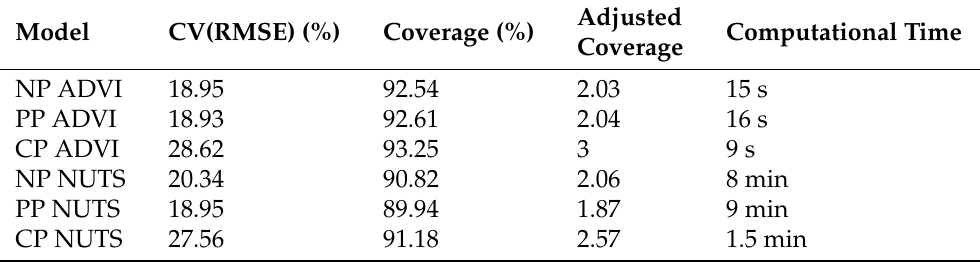
Figure 8. Median CV(RMSE) vs. median adjusted coverage obtained in Phase 4 of model comparison. Table 3. Results obtained in Phase 4 of model comparison. Median CV(RMSE), coverage and adjusted coverage are shown, as well as the average computational time required to estimate the model for a single building of the